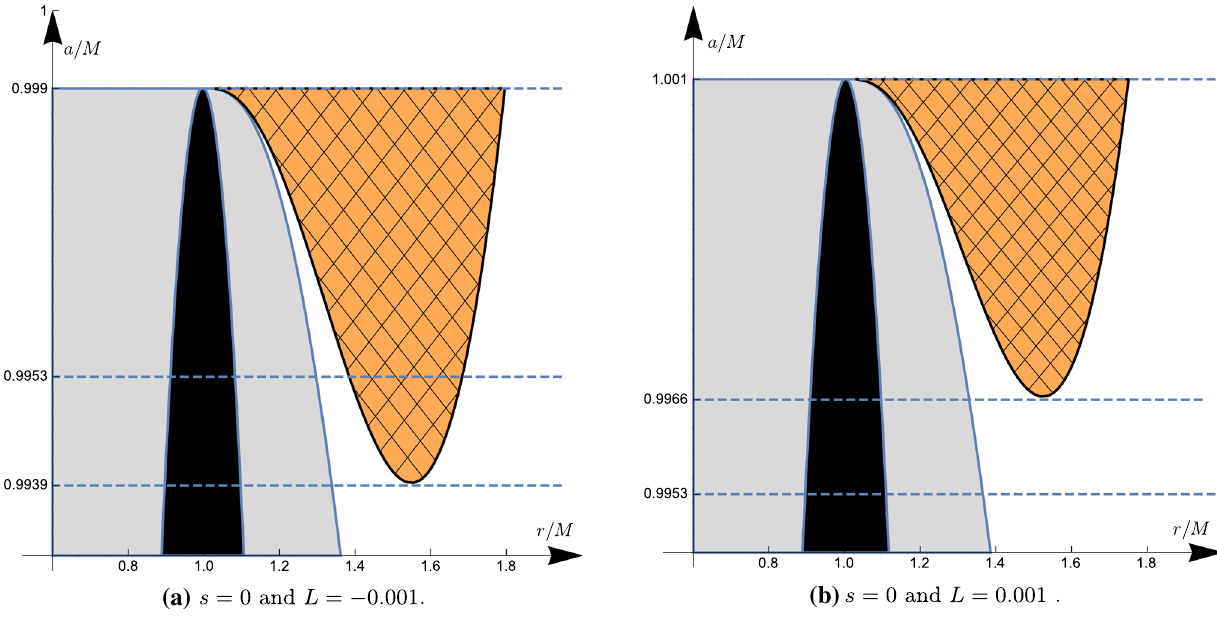
Fig. 3 The a − r parameter space with hatched region, where the greater than M . For the negative value of cosmological constant the Aschenbacheffectcanbeobservedfornon-spinningparticle.Theregion critical value of black hole spin is smaller than its value for the zero > 0. As one can see for and positive cosmological constant. The gray region shows unstable outside the event horizon corresponds to V + dr parameter’s region due to the ISCO consideration the positive cosmological constant the black hole spin is allowed to be